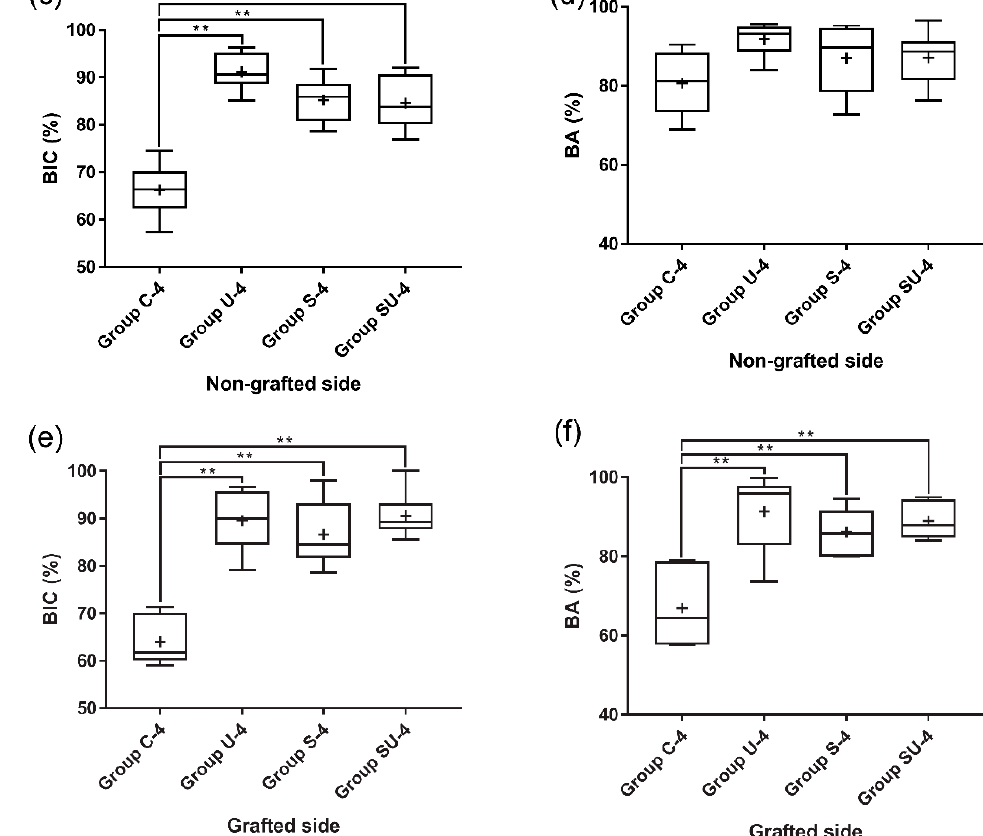
Figure 8. Histomorphometric analyses of the experimental groups. The grafted sides of 2-week groups were not analyzed due to a sparse amount of new bone in the vicinity of the implants. ( a ) BIC at the nongrafted side of the 2-week group; ( b ) BA at the nongrafted side of the 2-week group; ( c ) BIC at the nongrafted side of the 4-week group; ( d ) BA at the nongrafted side of the 4-week group; ( e ) BIC at the grafted side of the 4-week group; and ( f ) BA at the grafted side of the 4-week group. Asterisks indicate statistically significant differences among the groups (** p < 0.01). The lines inside the boxes indicate median values, and the cross signs inside the boxes indicate mean values. The borders of the boxes indicate the 25th and 75th percentiles. The whiskers indicate the minimum and maximum values. BIC, bone-to-implant contact; BA, bone area.